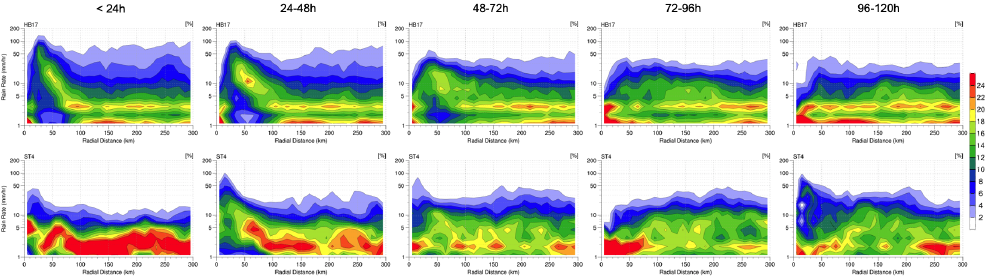
Figure 11. Similar to Figure 10 but for a 24-h interval. The top row is HB17’s CFRD and the bottom row is Stage IV. The first column is calculated from the first 24 h, the second is between 24 to 48 h, the third is 48 to 72 h, the fourth is 72 to 96 h, and the last is 96 to 120